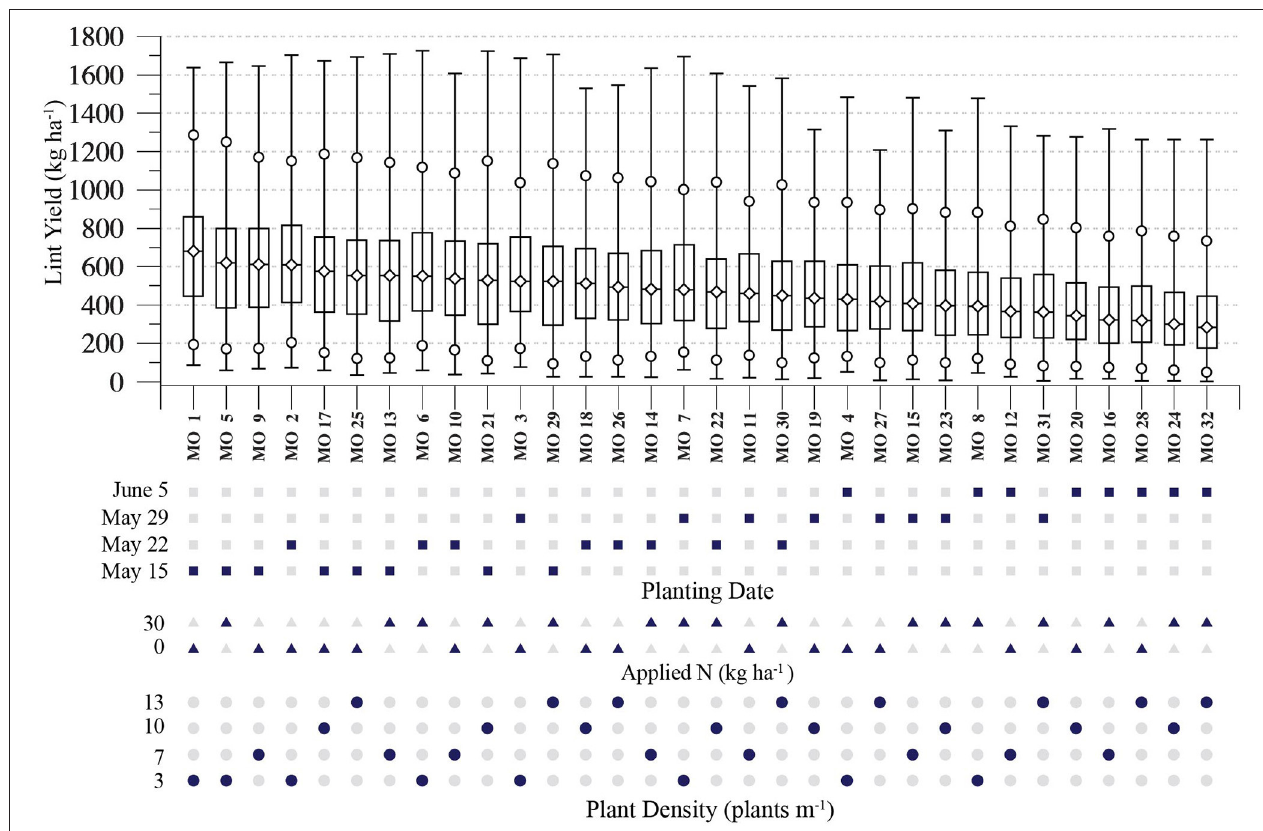
FIGURE 4 | As in Figure 3 , with distributions for each management option plotted in order from the highest to the lowest median lint yield.